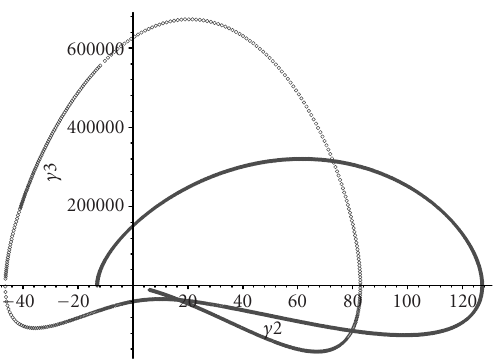
Figure 5.2. The orbit as it enters the region of the attractor, shown in the space of ˙ ε , ¨ ε , showing the transition from the initial conditions to the strange attractor. In τ , the curve starts on the ˙ ε axis to the right of the origin, and ends at the lower left of the origin.